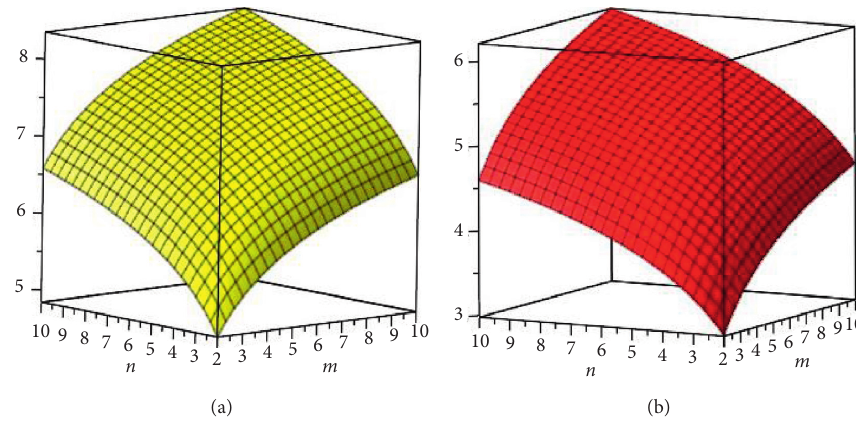
Figure 6: (a) Randi´c entropy for α � ( 1/2 ) ; (b) Randi´c entropy for α � (− 1/2 )